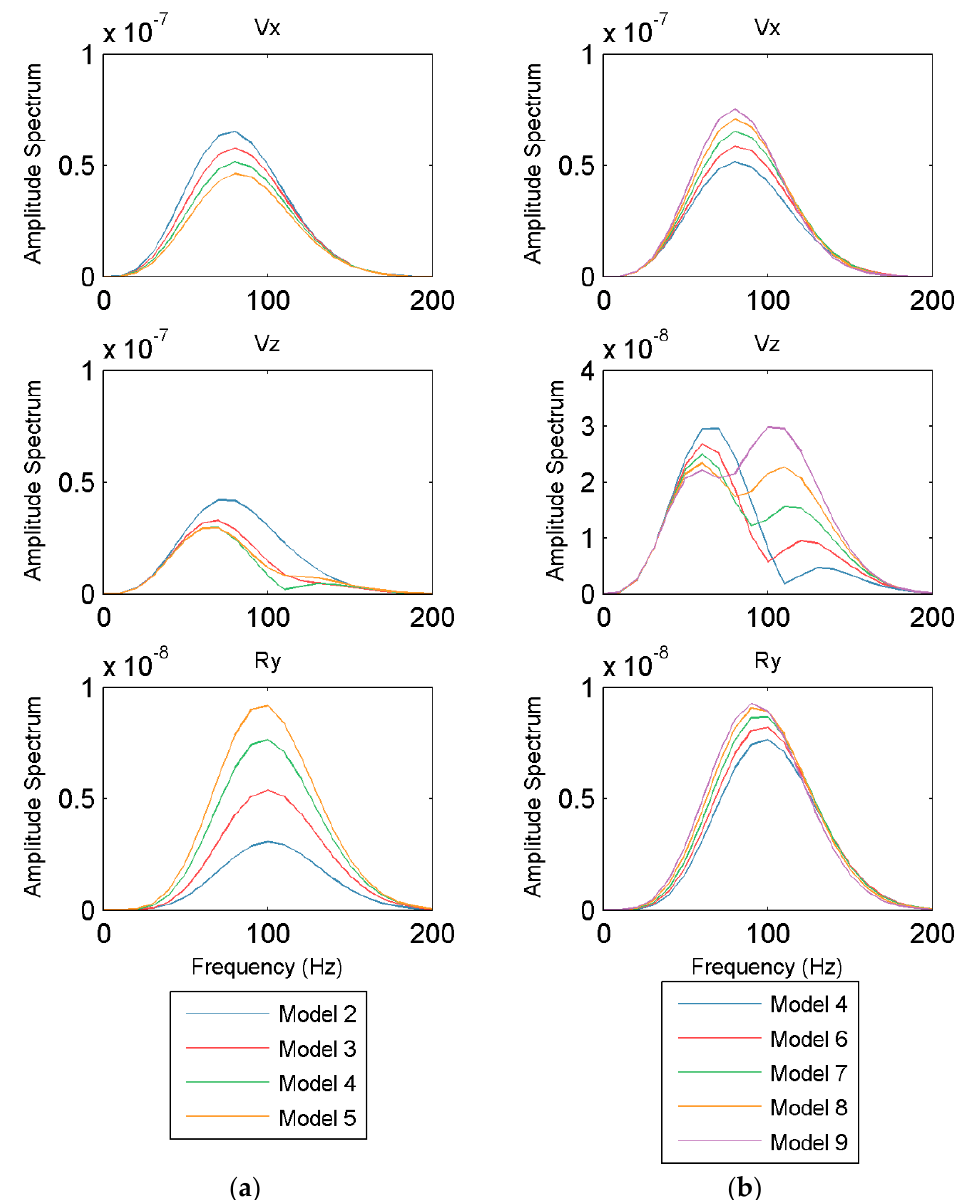
Figure 10. Influence of anisotropy parameters on amplitude spectra of the 90th trace generated from the expansion source: ( a ) when ε varies; ( b ) when δ varies.